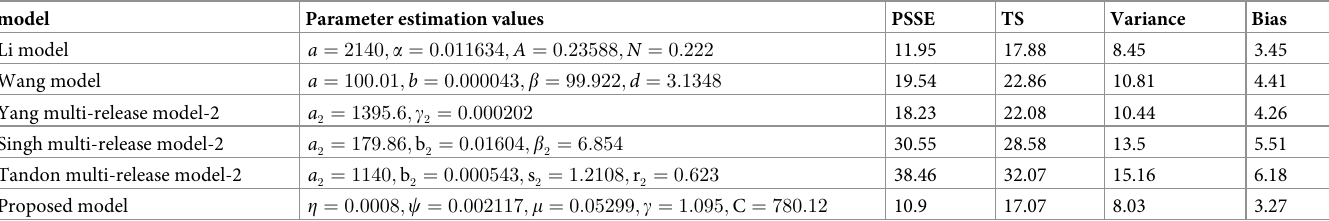
Table 6. Comparison of the predictive performance of models using 90% of fault data (DS2-2). model